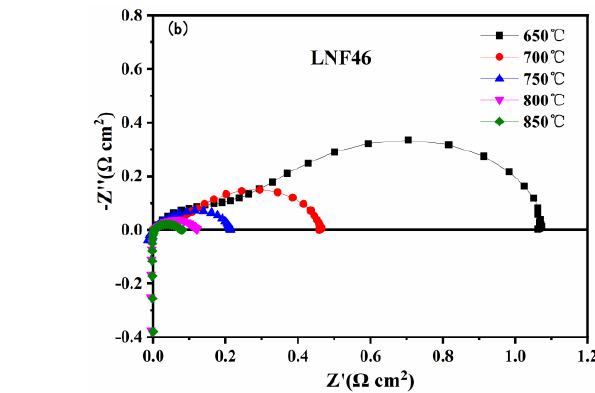
conditions; ( b ) Thermogravimetric analysis on LSNF9146 and LNF46 oxides after CH 4 treatment at 900 °C for 10 h.